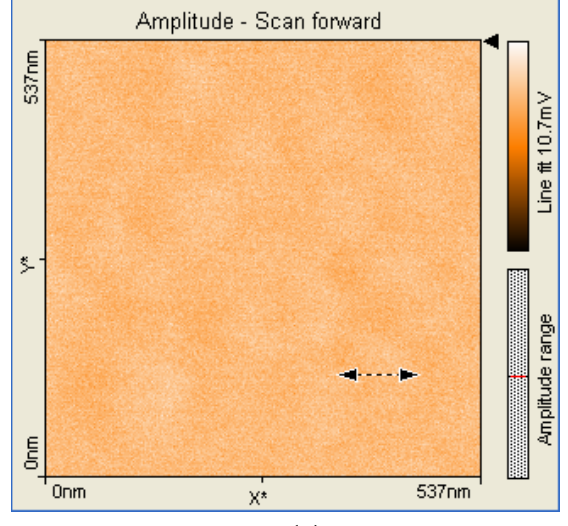
Figure 17. 2D (a) and 3D (b) AFM images (537×537nm) and particle analysis of the hybrid material